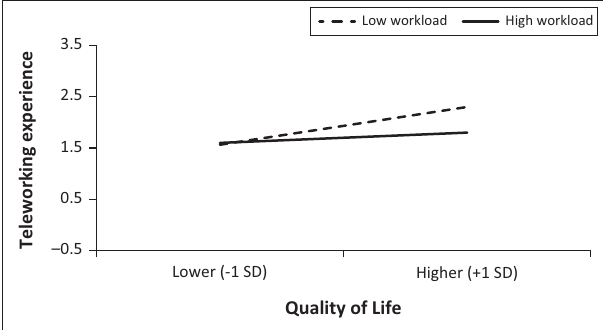
FIGURE 2: Simple slopes between the quality of life and teleworking experience at different levels of